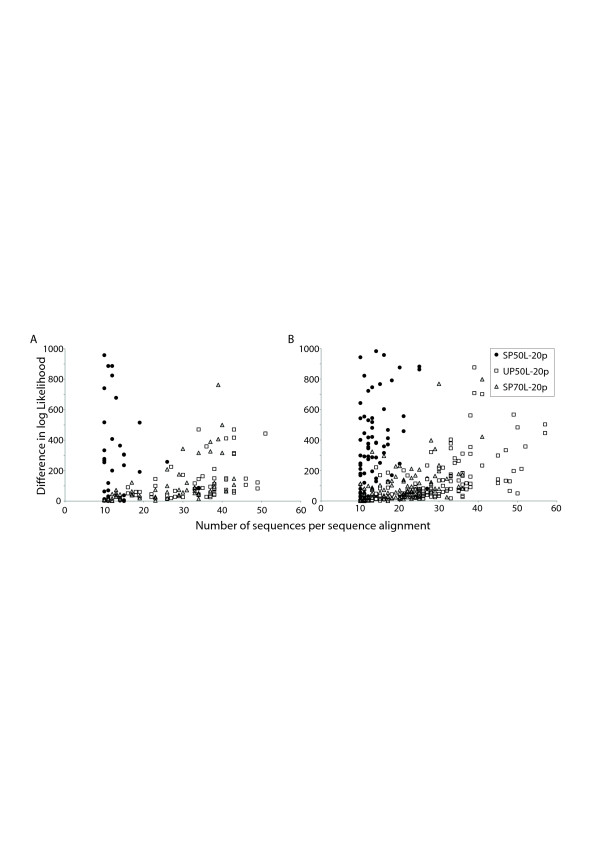
Correlation of difference in log likelihood values (dLLs) vs. Number of sequences per MSA. The figures plot the dLL values on the Y-axis and number of sequences per MSA on X-axis for A) Interacting proteins and B) Non-interacting proteins. For both cases, values for the 20p version of the 3 datasets SP-50 L, UP-50 L and UP-70 L are shown.